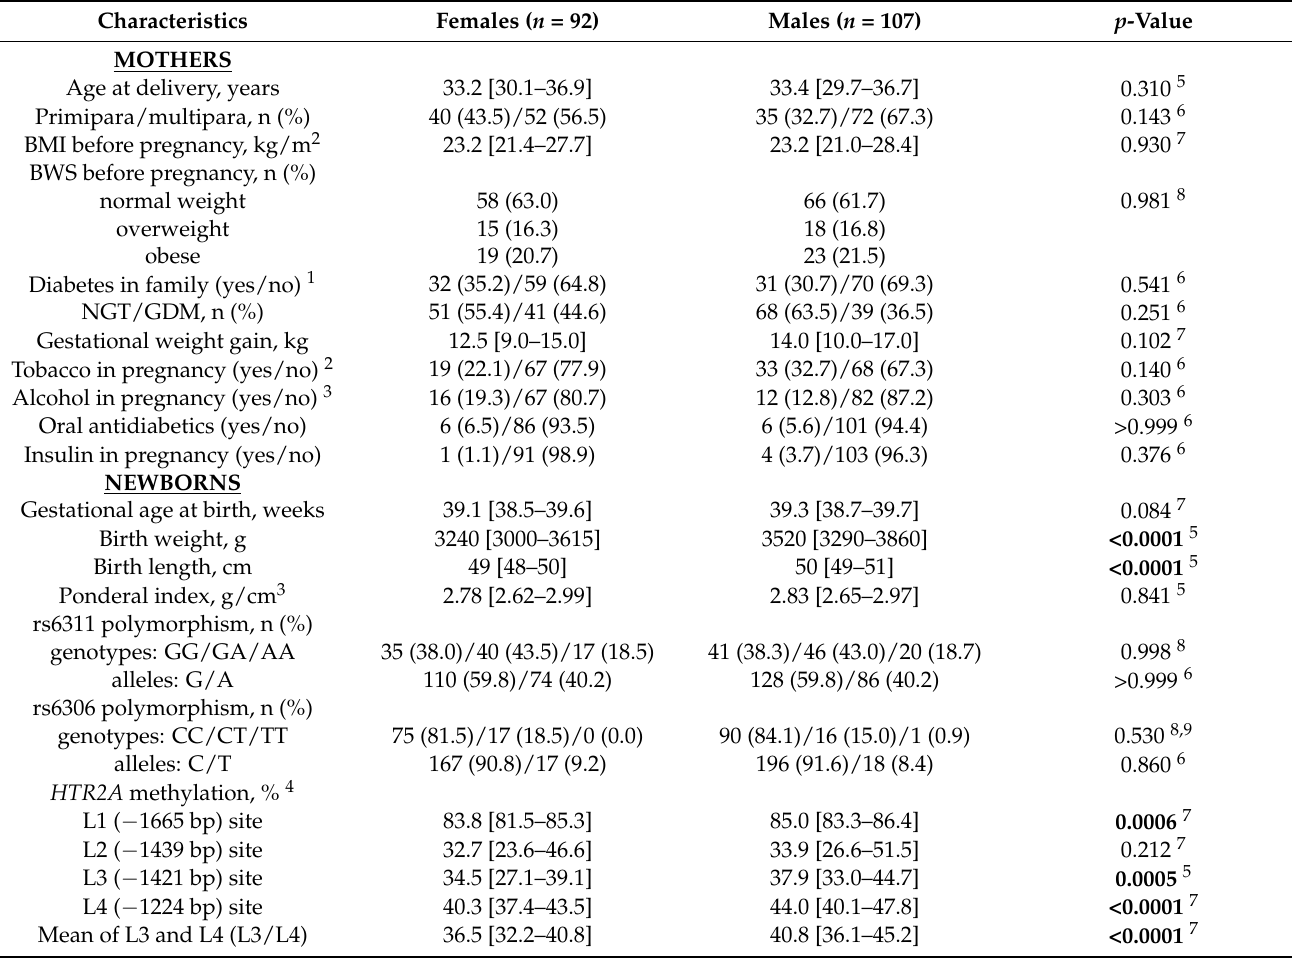
Table 1. Characteristics of the study sample by sex of